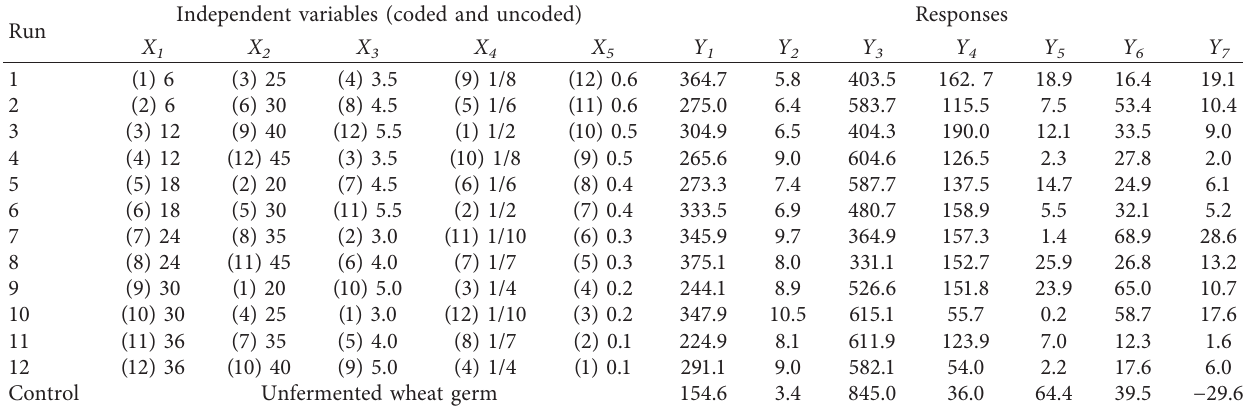
Table 1: Uniform design for lactic acid bacteria fermentation of wheat germ. Independent variables (coded and uncoded) Run